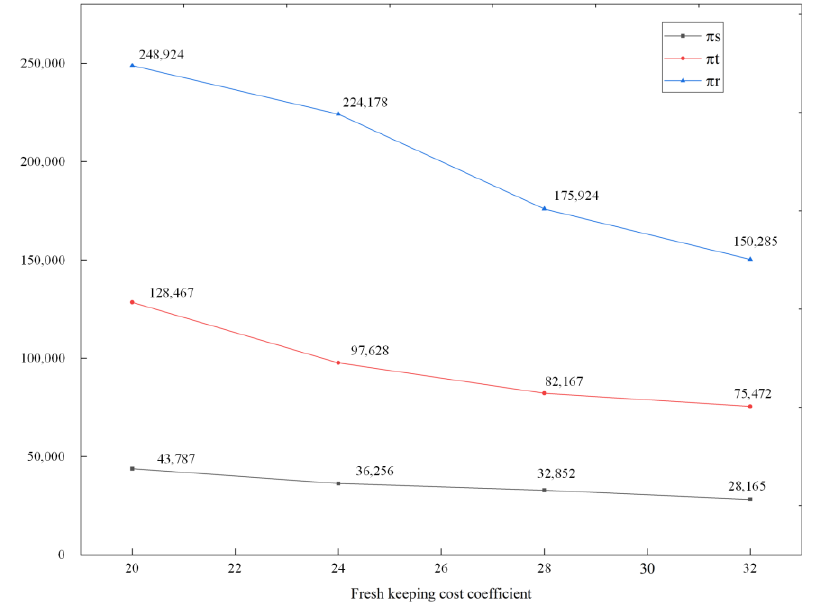
Figure 8. The impact of the fresh-keeping cost coefficient on the profits of all parties in the supply